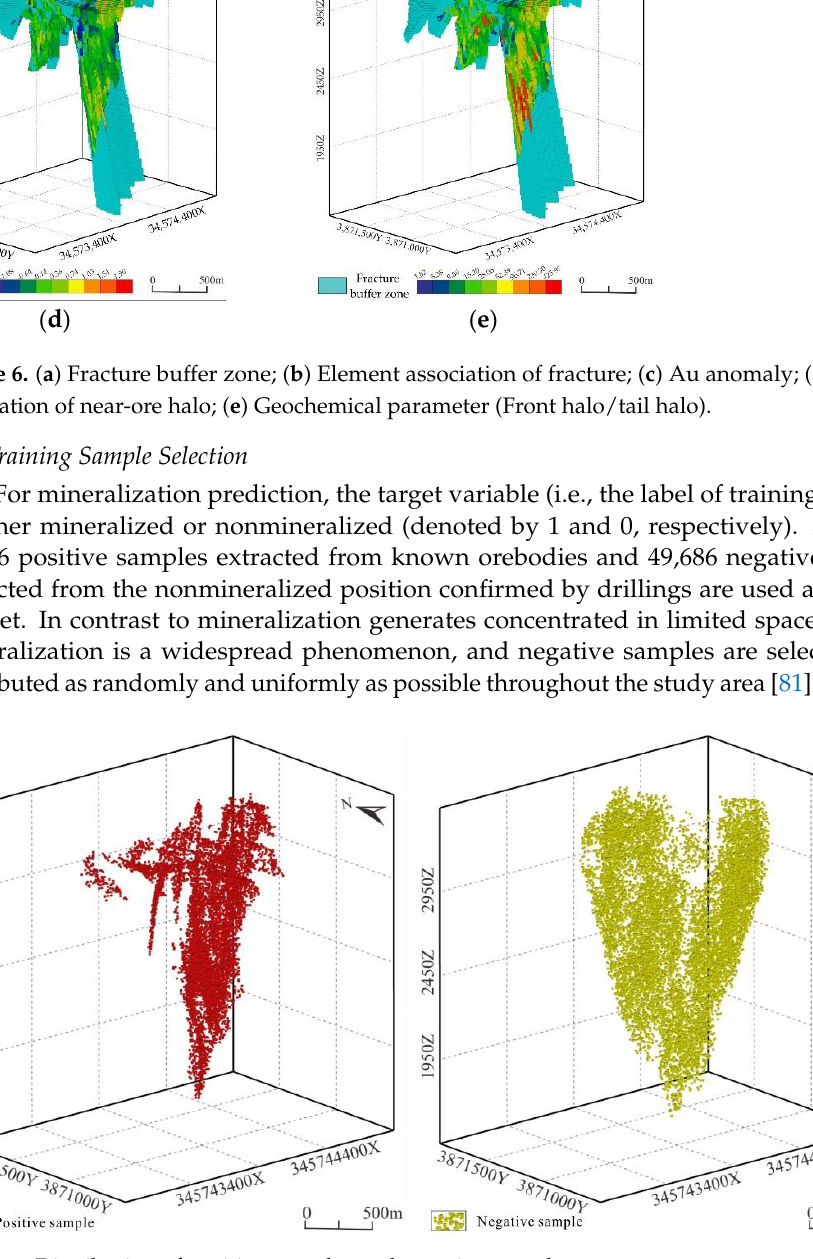
Figure 7. Distribution of positive samples and negative